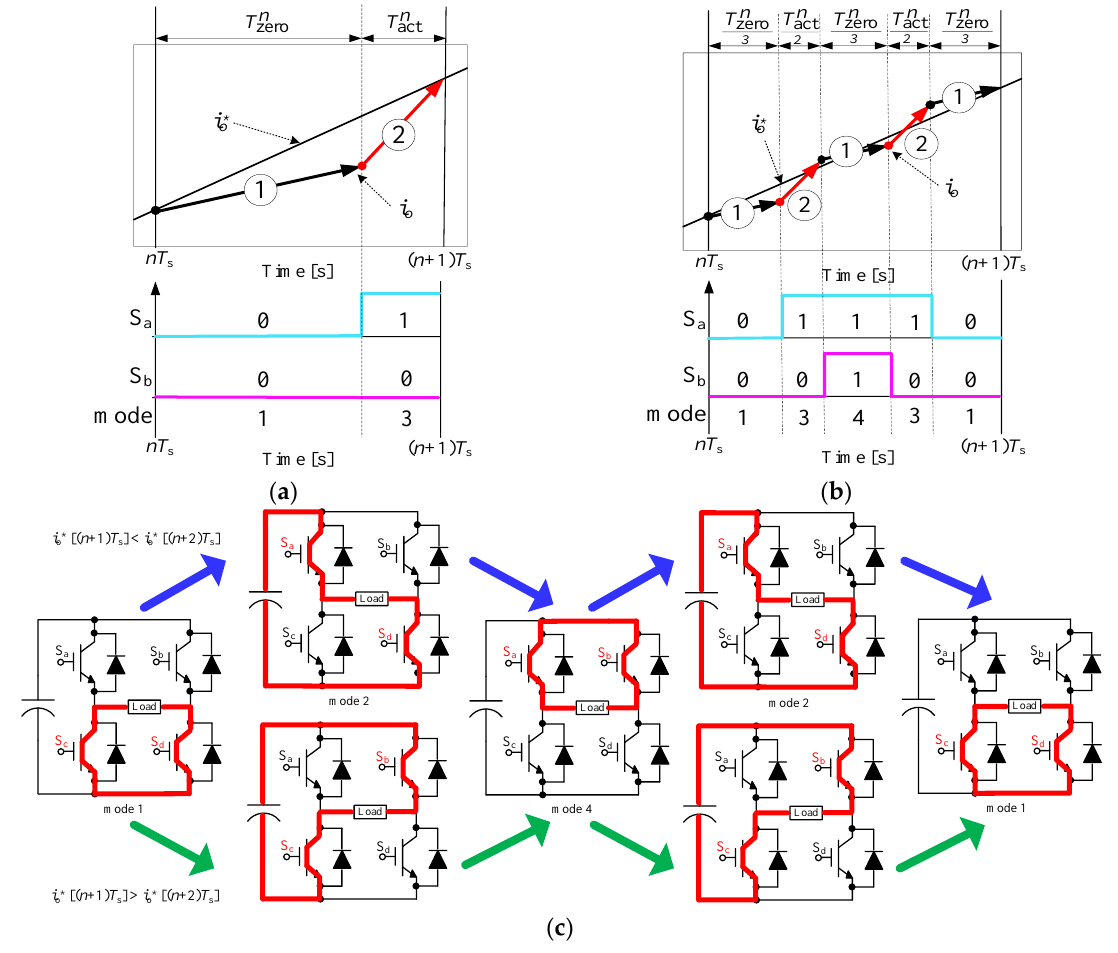
Figure 4. Illustrative operation of the proposed method. ( a ) Without division of time intervals; ( b ) switching patterns of the proposed method; ( c ) circuit operation of the proposed method during one sampling period.